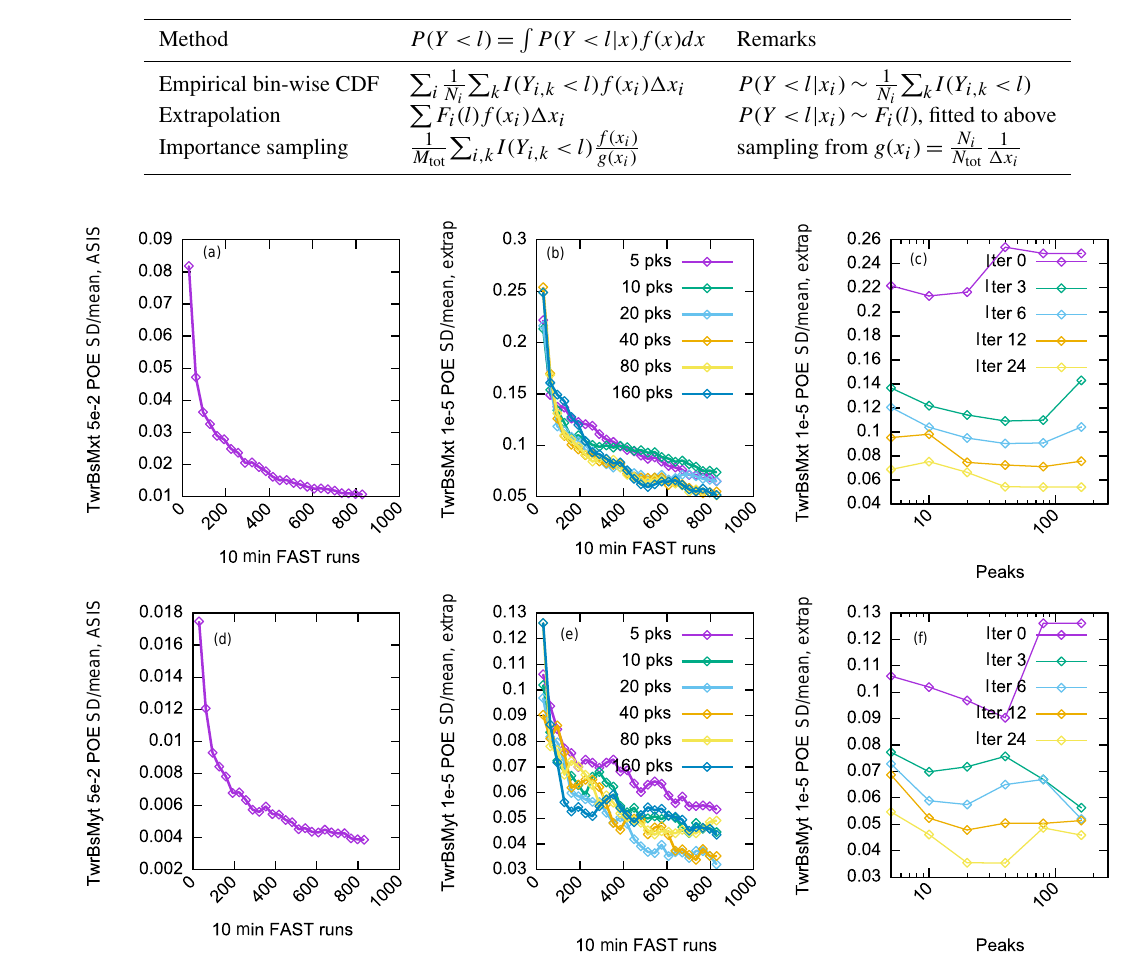
Figure 3. Summarizing the convergence of tower base load estimates using extrapolation and ASIS estimates over 100 independent runs. The top row is side–side; the bottom is fore–aft. The y -axis units are the ratio of the standard deviation to the mean estimate (relative standard deviation, measuring convergence). The x axis is the number of FAST runs (measuring computational expense). The target POE for the empirical ASIS estimate (a, d) is 5 × 10 − 2 and for the extrapolation estimate (b, c, e, f) is 10 − 5 . Adaptively selecting samples, in a way designed to accelerate the convergence of the empirical estimate (ASIS, a, d ), also accelerates the convergence of the extrapolation estimates (b, c, e, f) . There is a somewhat weak dependence on the number of peaks used for extrapolation, but M pks ∼ 40 appears robust for both loads. The side–side load estimate has larger initial relative variance because (as shown above in Fig. 1) its extremes occur at high winds, but its relative variance is reduced more quickly by the adaptive procedure than the fore–aft